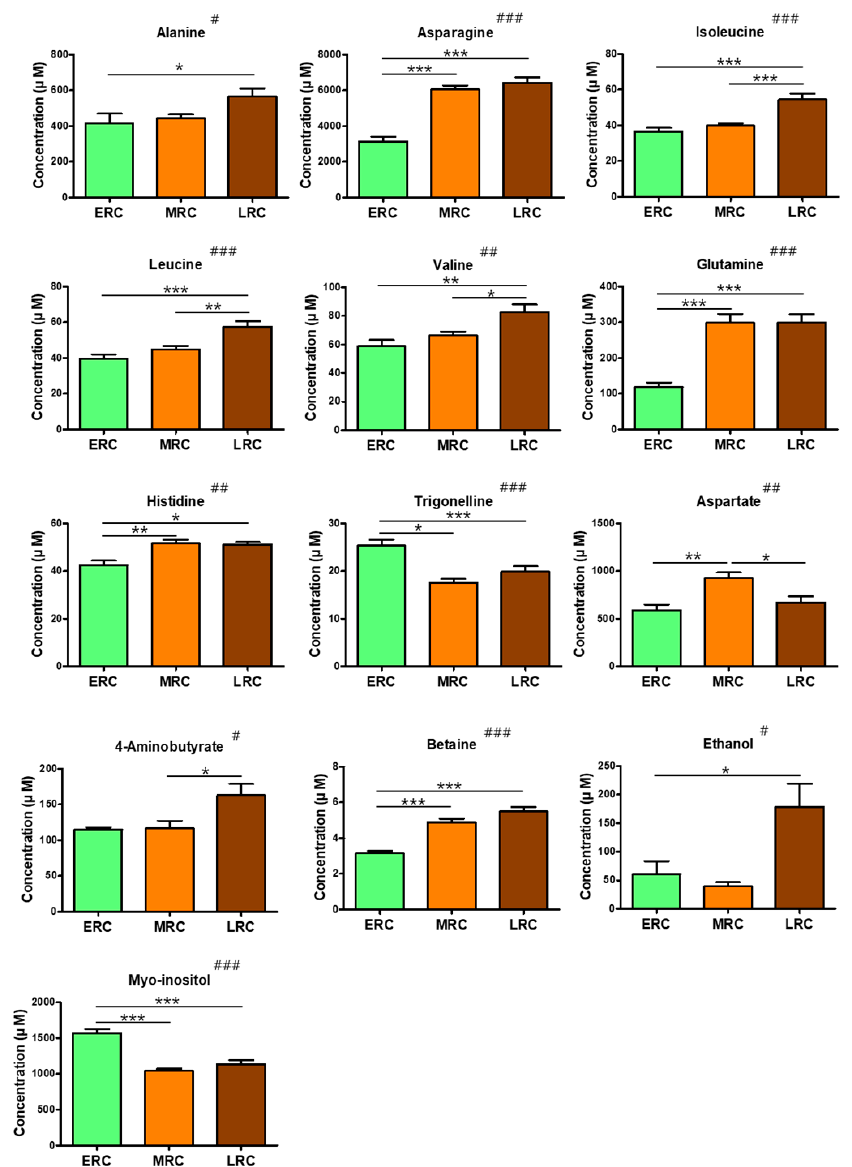
Figure 5. Levels of metabolites in early-ripening cultivars, mid-ripening cultivars and late-ripening cultivars of C. crenata chestnut. Kruskal–Wallis tests yielded significant differences determined by Dunn’s multiple comparison post hoc tests using GraphPad Prism 5.0. Significant differences by Kruskal–Wallis tests are represented as # p < 0.05, ## p < 0.01, and ### p < 0.001, and by Dunn’s multiple comparison post hoc tests are represented as * p < 0.05, ** p < 0.01, and *** p < 0.001. Error bars indicate means ± standard deviation. Letters on the horizontal axis represent: ERC, early-ripening cultivar; MRC, mid-ripening cultivar; LRC, late-ripening